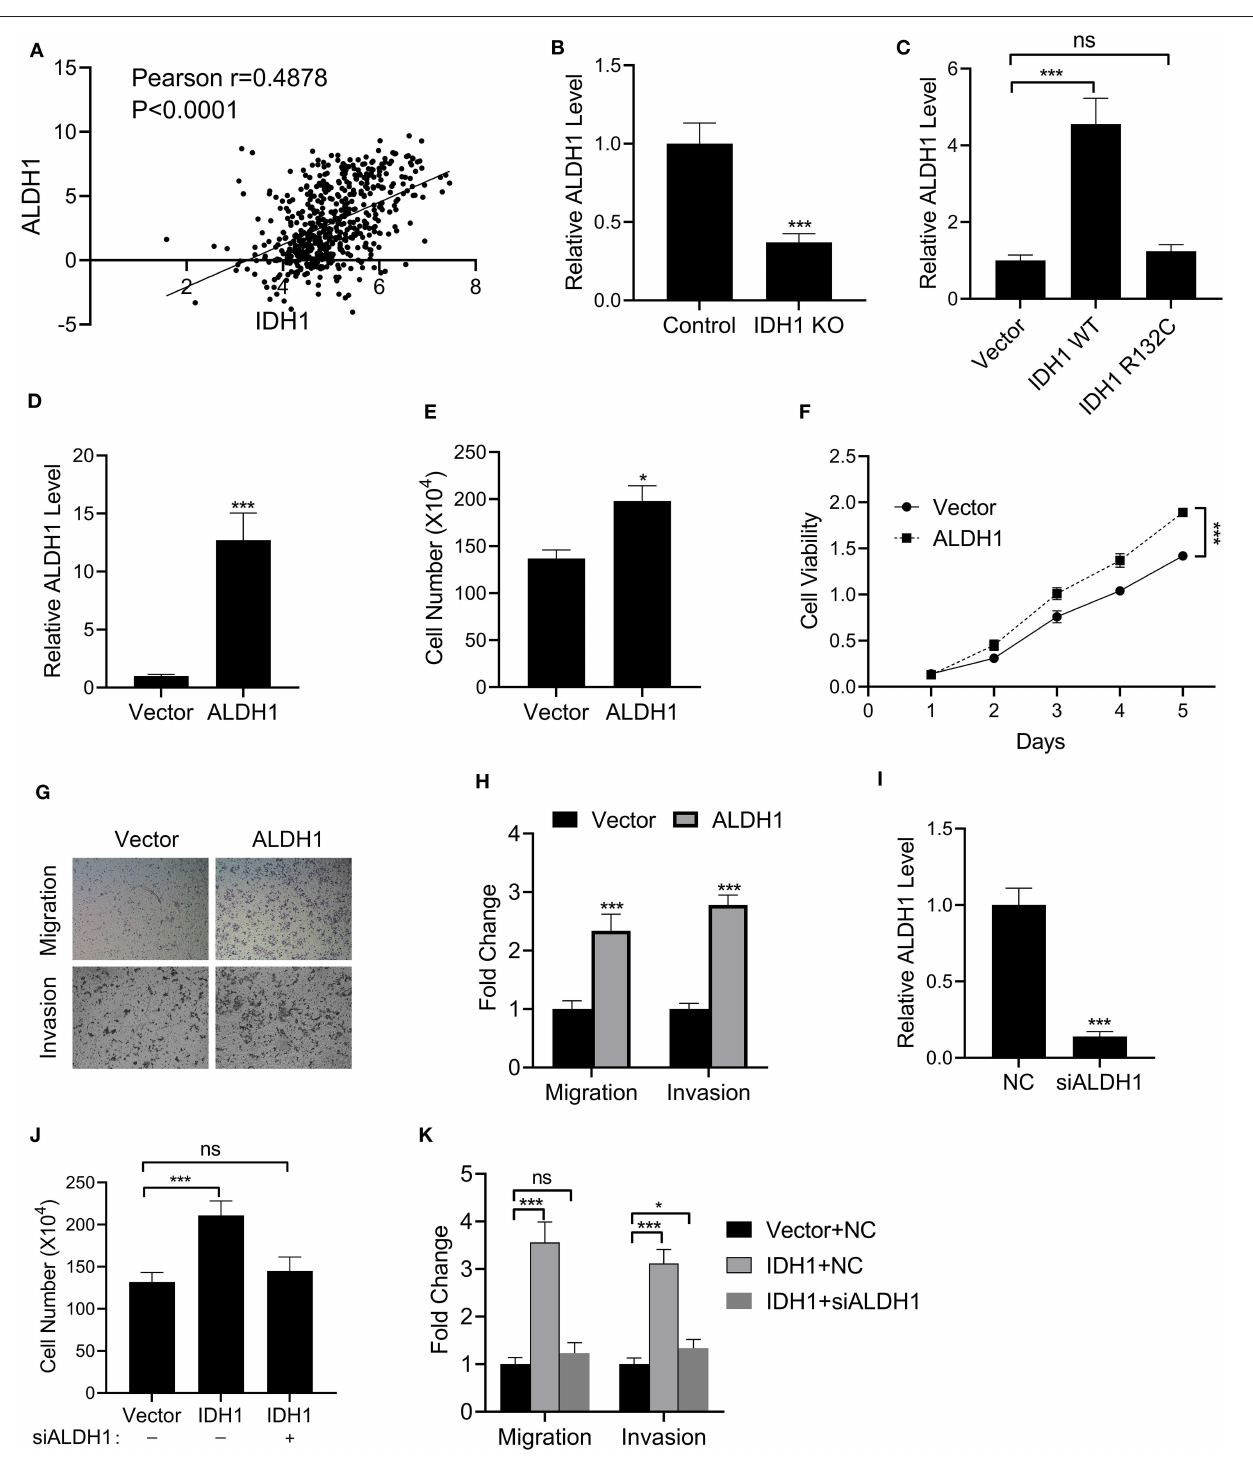
FIGURE 5 | IDH1 regulated the expressions of ALDH1. (A) The correlation of IDH1 and ALDH1 expression in the patients with cholangiocarcinoma was analyzed using ChIPbase dataset. (B,C) qPCR was used to determine the levels of ALDH1 in REB cells, IDH1 KO REB cells, and IDH1 KO REB cells transfected with vector, wildtype IDH1 or IDH1 R132C mutation plasmid. (D) qPCR was used to determine the relative expressions of ALDH1 in REB cells transfected with ALDH1 expression plasmid. (E,F) Cell count assay and MTT assay were used to determine the cell viabilities of REB cells transfected with vector or ALDH1 expression plasmid. (G,H) Cell migration and invasion assay of REB cells transfected with vector or ALDH1 expression plasmid were determined using Transwell and the values in each group